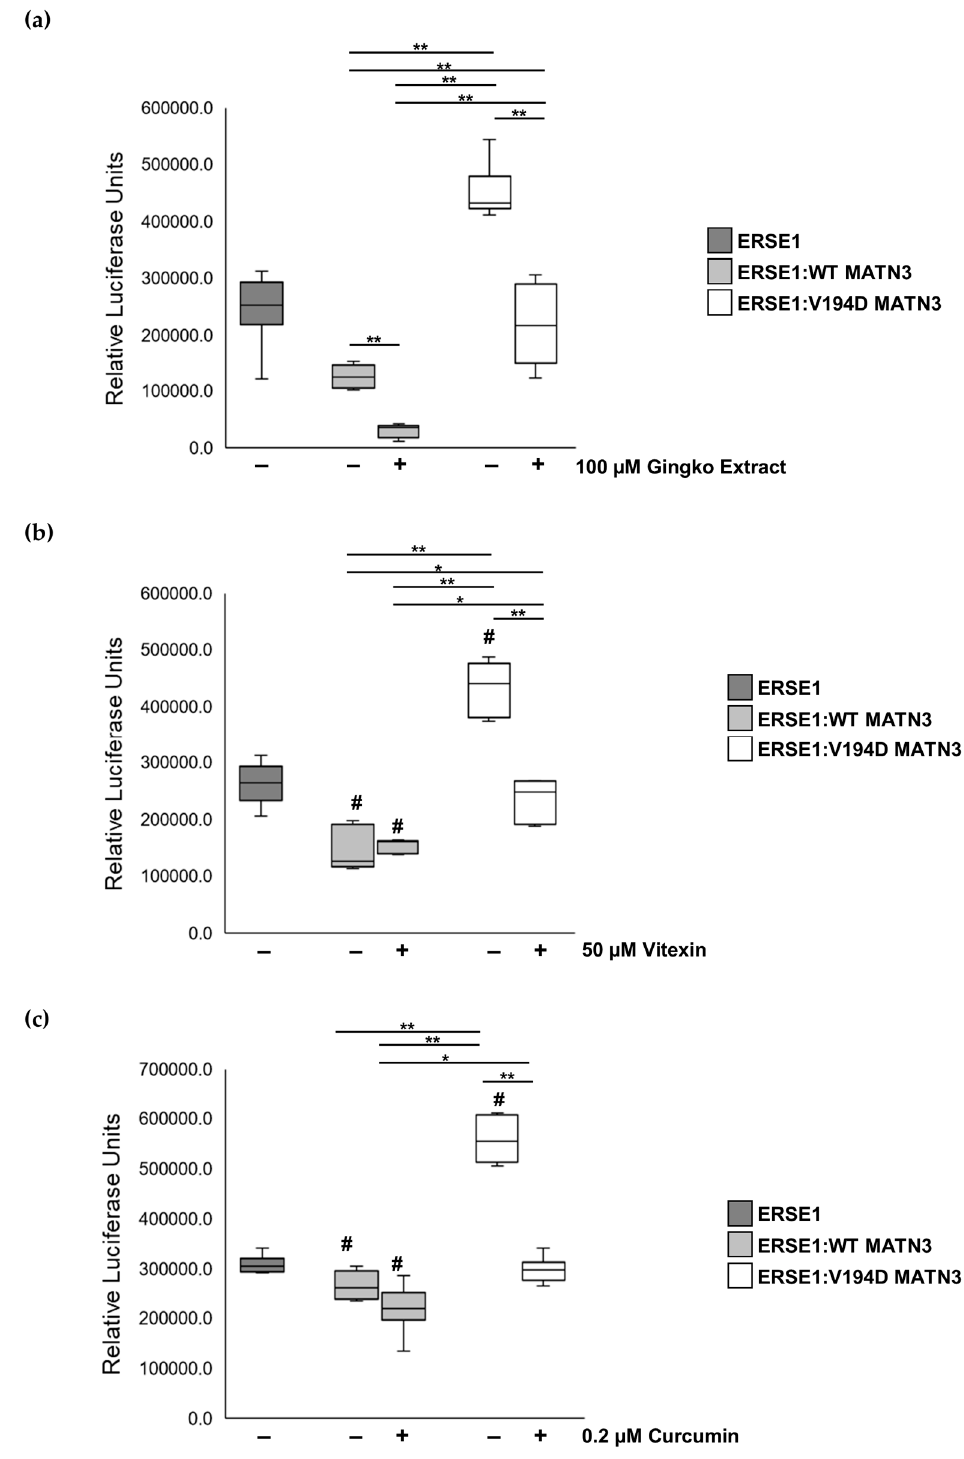
Figure 1. Administration of curcumin and vitexin ameliorates ER stress caused by the retention of mutant matrilin-3. HELA cells were co-transfected with the ER stress luciferase reporter plasmid (ERSE1) and either wild-type (ERSE1:WT MATN3) or V194D mutant matrilin-3 (ERSE1:V194D MATN3) and cells were cultured in the presence/absence of 100 µM Gingko extract, 50 µM vitexin, or 0.2 µM curcumin. ER stress was monitored using a luciferase assay. Mutant matrilin-3-induced ER stress in HELA cells was identified by increased luciferase activity. ( a ) Luciferase activity is significantly reduced in both ERSE1:WT MATN3 and ERSE1:V194D MATN3 cells following treatment with Gingko extract, indicating that Gingko extract not only significantly reduces ER stress in V194D